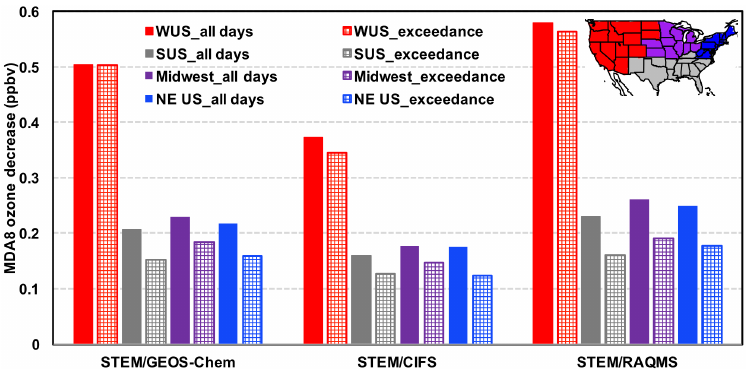
Figure 10. STEM R (MDA8, EAS, 20%) for May–June 2010 in four US subregions (defined in the inset panel, also consistent with the definitions in Figs. 2 and S4 and Tables 2 and 3), averaged on all days (bars with solid fill) and only on the days when the simulated total MDA8 O 3 concentrations were over 70ppbv (bars with grid pattern fill). The results from the STEM runs using GEOS-Chem, ECMWF C-IFS, and RAQMS boundary conditions are shown separately.